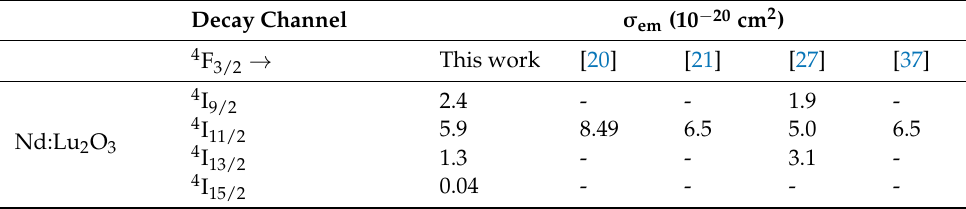
Table 3. Emission cross-sections of Nd:Lu 2 O 3